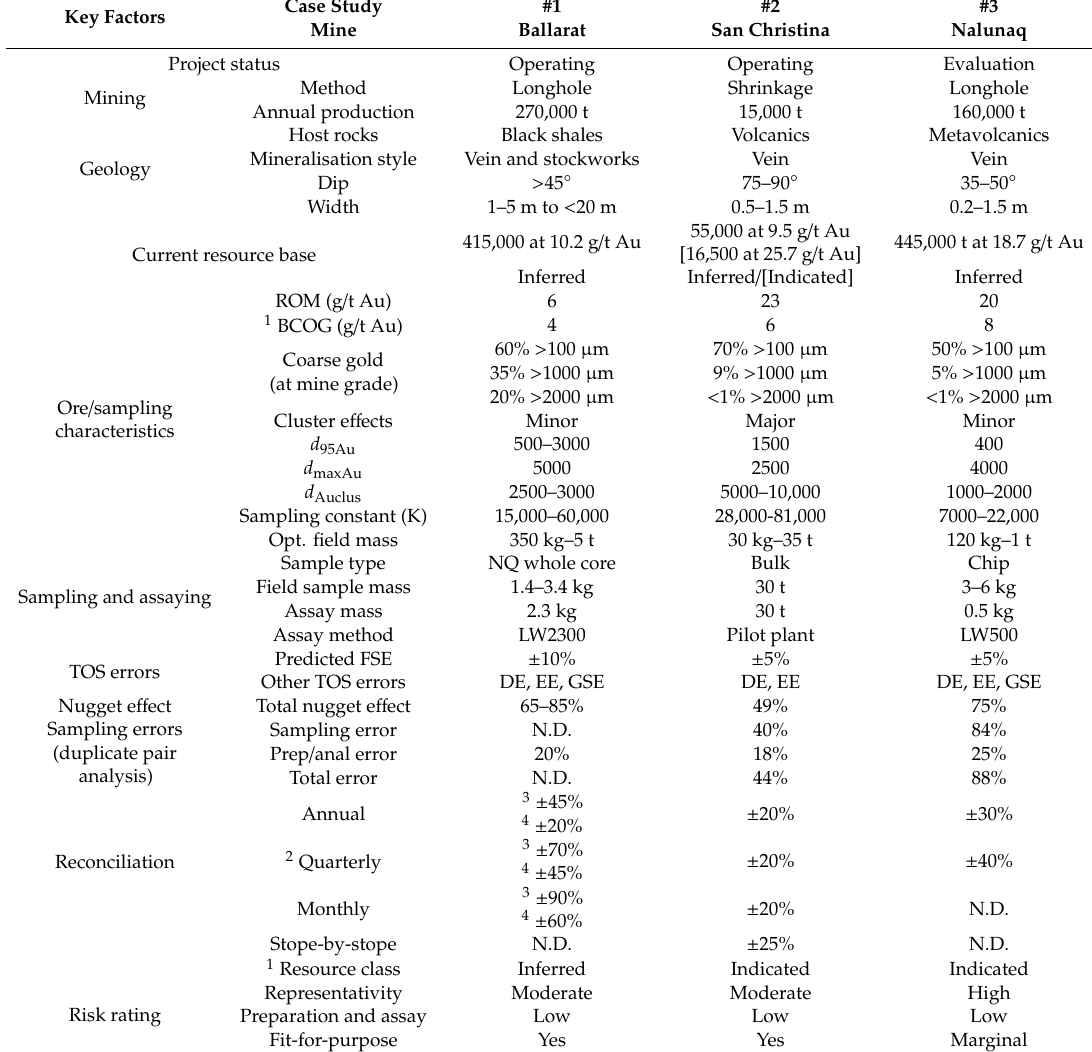
Table 34. Summary of key factors and performance of grade control samples for each case